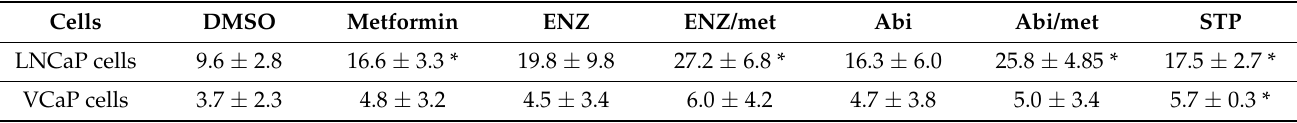
Table 1. Annexin V/PI staining of LNCaP and VCaP cells treated with metformin, ENZ, Abi, or staurosporine as determined by flow